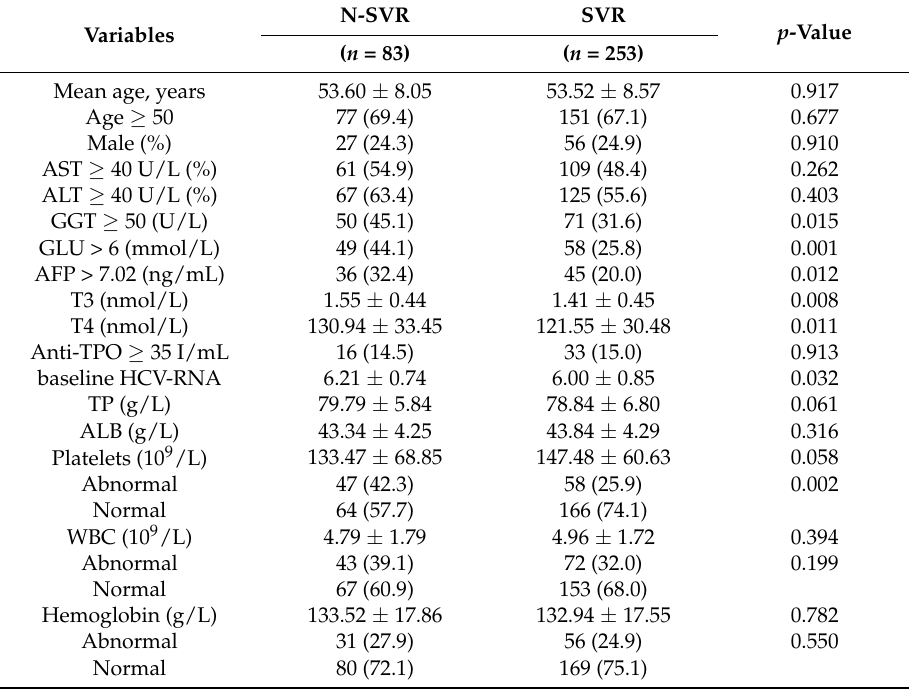
Table 1. Baseline characteristics of chronic hepatitis C patients treated with